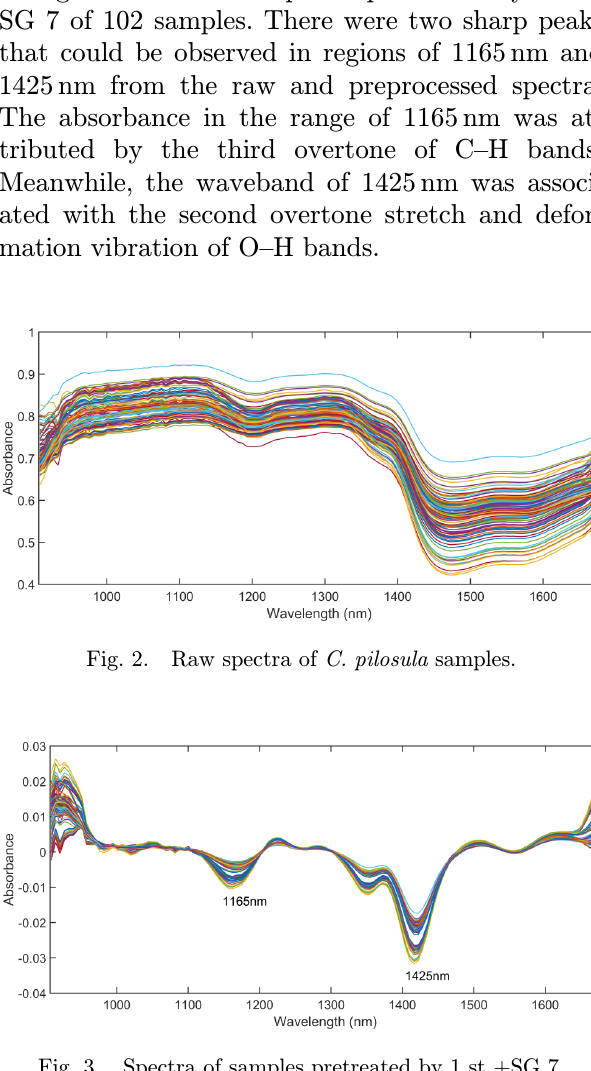
Fig. 3. Spectra of samples pretreated by 1 st þ SG